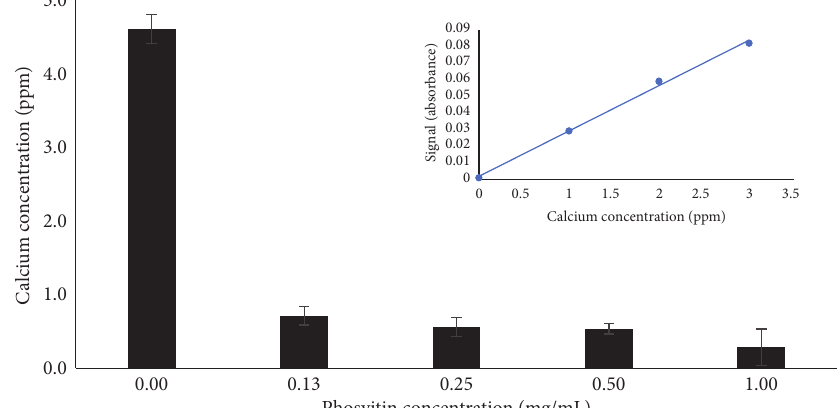
Figure 4: Effect of addition of phosvitin on calcium release form hydroxyapatite discs exposed to the month-long acid-damage immersion assay. Discs were treated with phosvitin solutions ranging from 0.13 to 1.0mg/mL phosvitin. FAAS measurements of the calcium released into solution were taken at the initial onset of the experiment and also after thirty days. A correction for calcium contributed by the phosvitin solution was made by subtracting the initial time measurement from that after thirty days. Inset: standard curve relating calcium con- centration to FAAS signal; error measurements were calculated but were inside the span of the